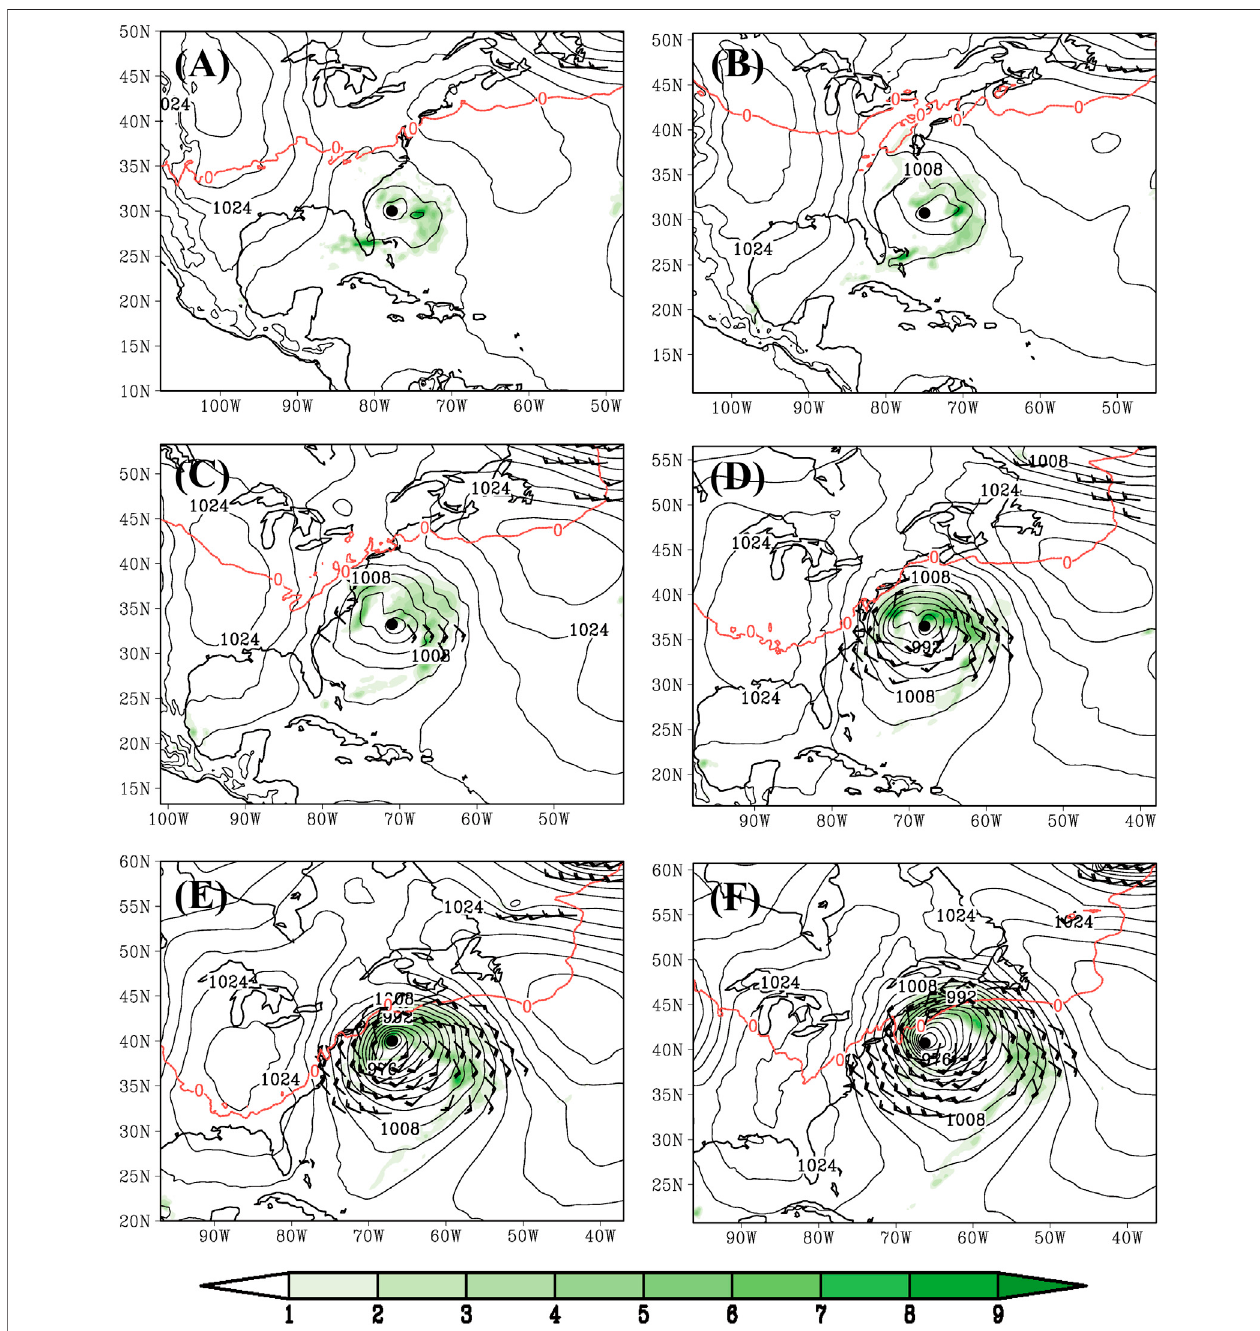
FIGURE2| Sea level pressure (solid, 4 hPaintervals), 1-haccumulatedprecipitation (shaded, 1 mmintervals),gale (bard, ≥ 12 m s − 1 )and 0 ° temperatureat2 m (red) at (A) 12 UTC 25, (B) 18 UTC 25, (C) 00 UTC 26, (D) 06 UTC 26, (E) 12 UTC 26, and (F) 18 UTC March 26, 2014. The large solid dot denotes the SEC center.